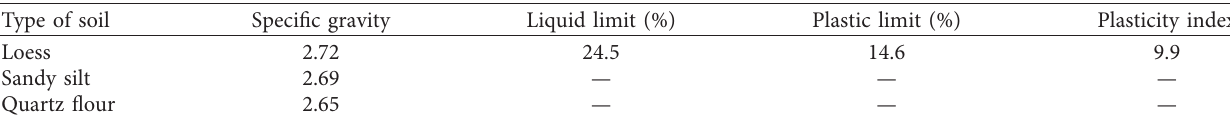
Figure 2: Comparison of test materials. (a) Sandy silt. (b) 400 mesh quartz flour. (c) 2500 mesh quartz flour. (d) 40–70 mesh quartz sand. Table 1: Basic physical properties of test soil.